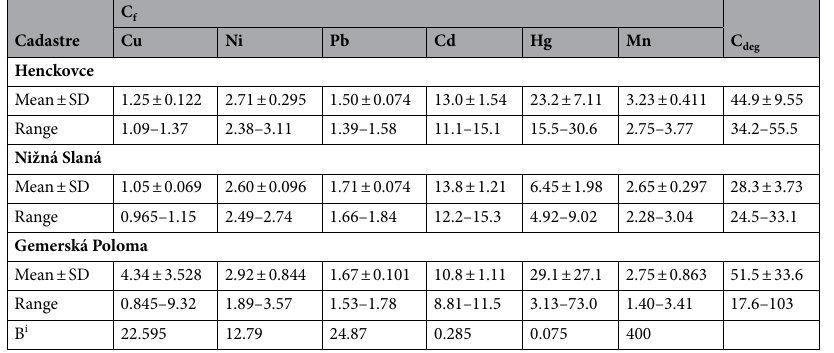
Table 2. Contamination factor (C f ) and degree of contamination (C deg ). B i the background values of risk elements in